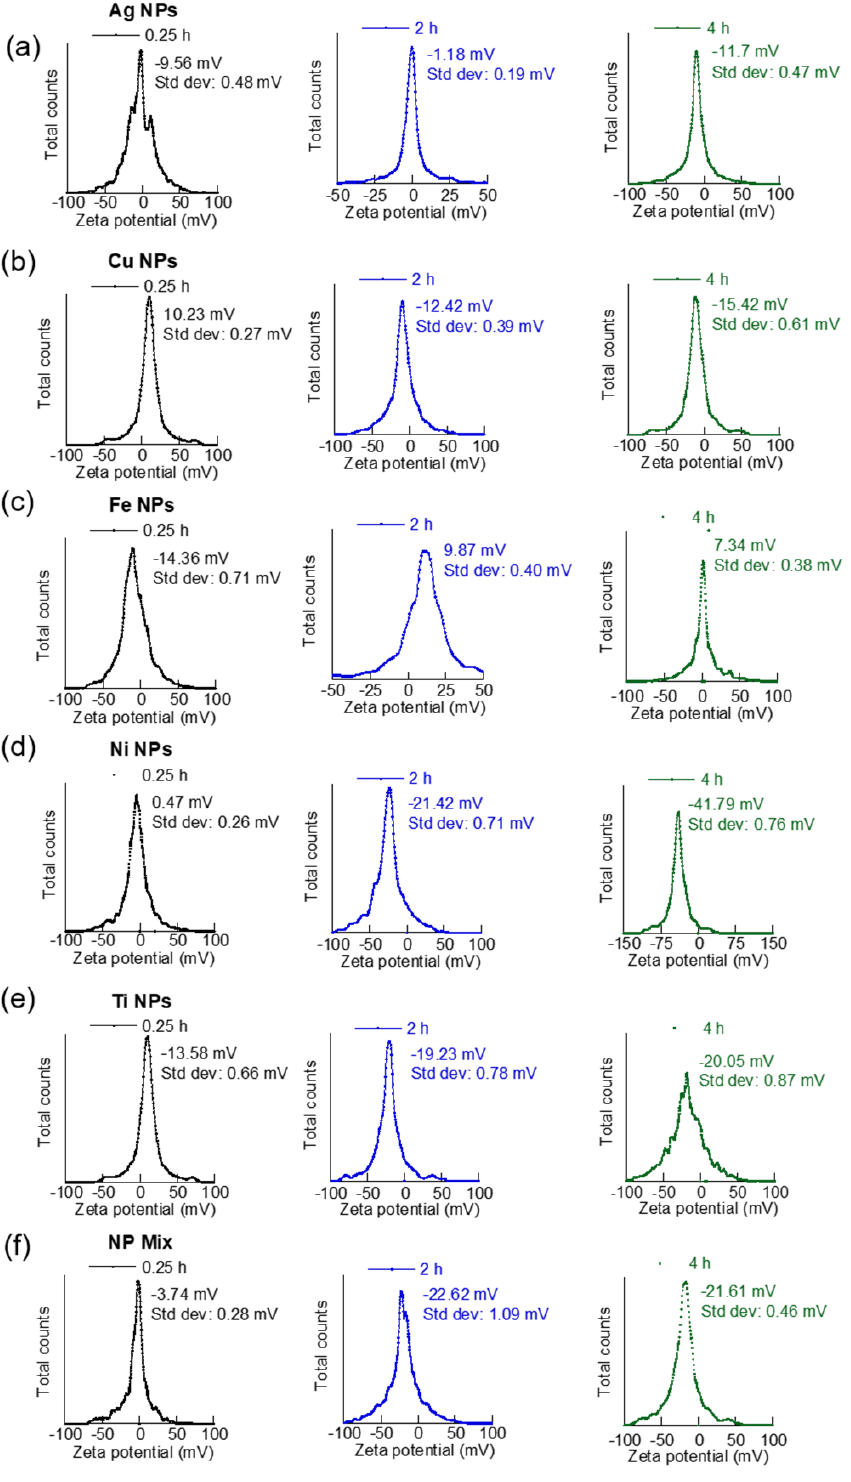
Figure 3. Zeta potential plots of different NPs at 0.25, 2, and 4 h of suspension. ( a ) Ag NPs, ( b ) Cu NPs, ( c ) Fe NPs, ( d ) Ni NPs, ( e ) Ti NPs, and ( f ) Co-existing MNP mix.